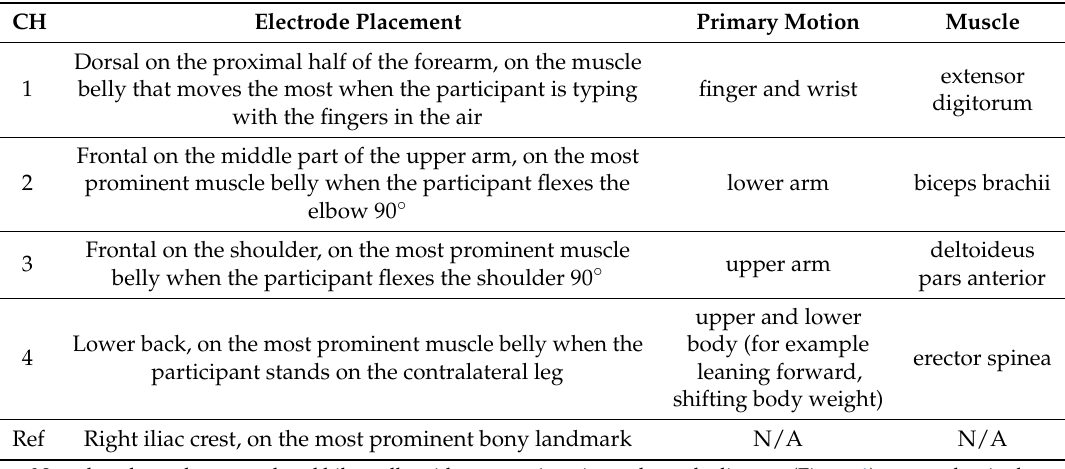
Figure 1. ( a ) 8-CH-EMG+ prototype with electrodes, wires, two data processing units (1), data logger (2), and power bank (3). ( b ) Participant performing the deskwork task with 8-CH-EMG+ and indirect calorimeter (sleeve rolled up to show the electrodes). Table 2. Instruction for the electrode placement of each EMG channel (CH) including primary motion that the sensor detect and the corresponding muscle names.